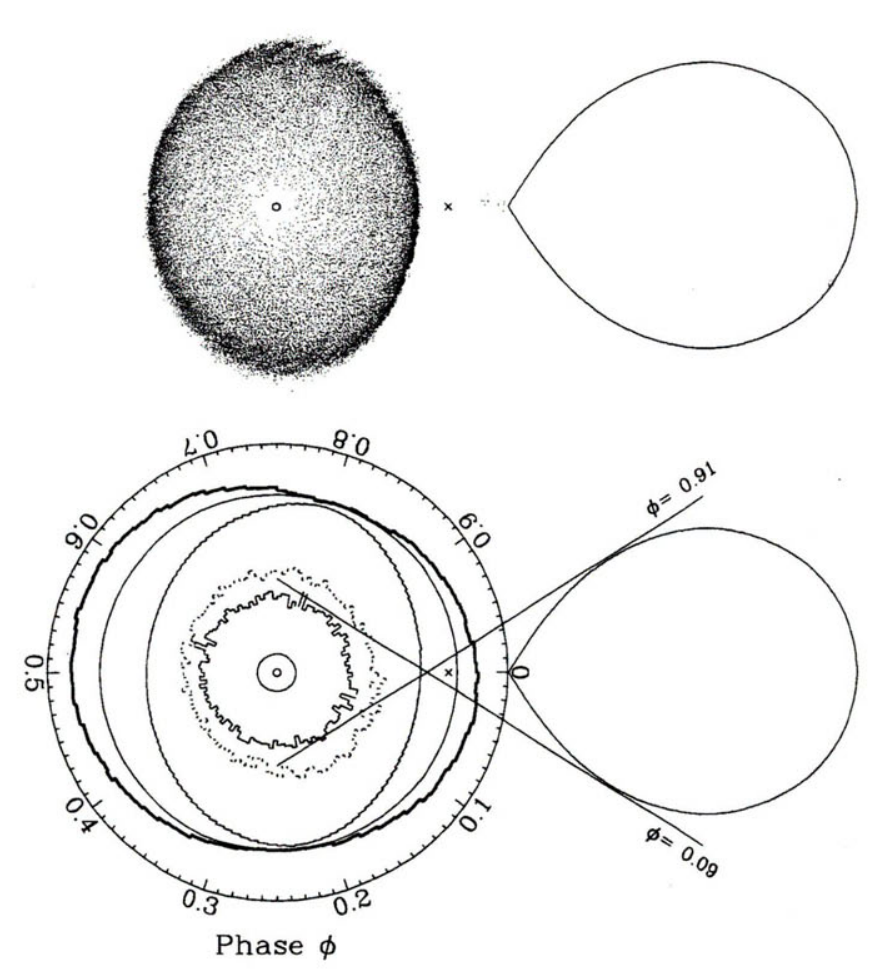
Fig. 2. The (x, y ) disk projection. In the top panel, 20 000 particles are shown and the system center of mass is indicated with an " x". The bottom panel shows several features, as described in the